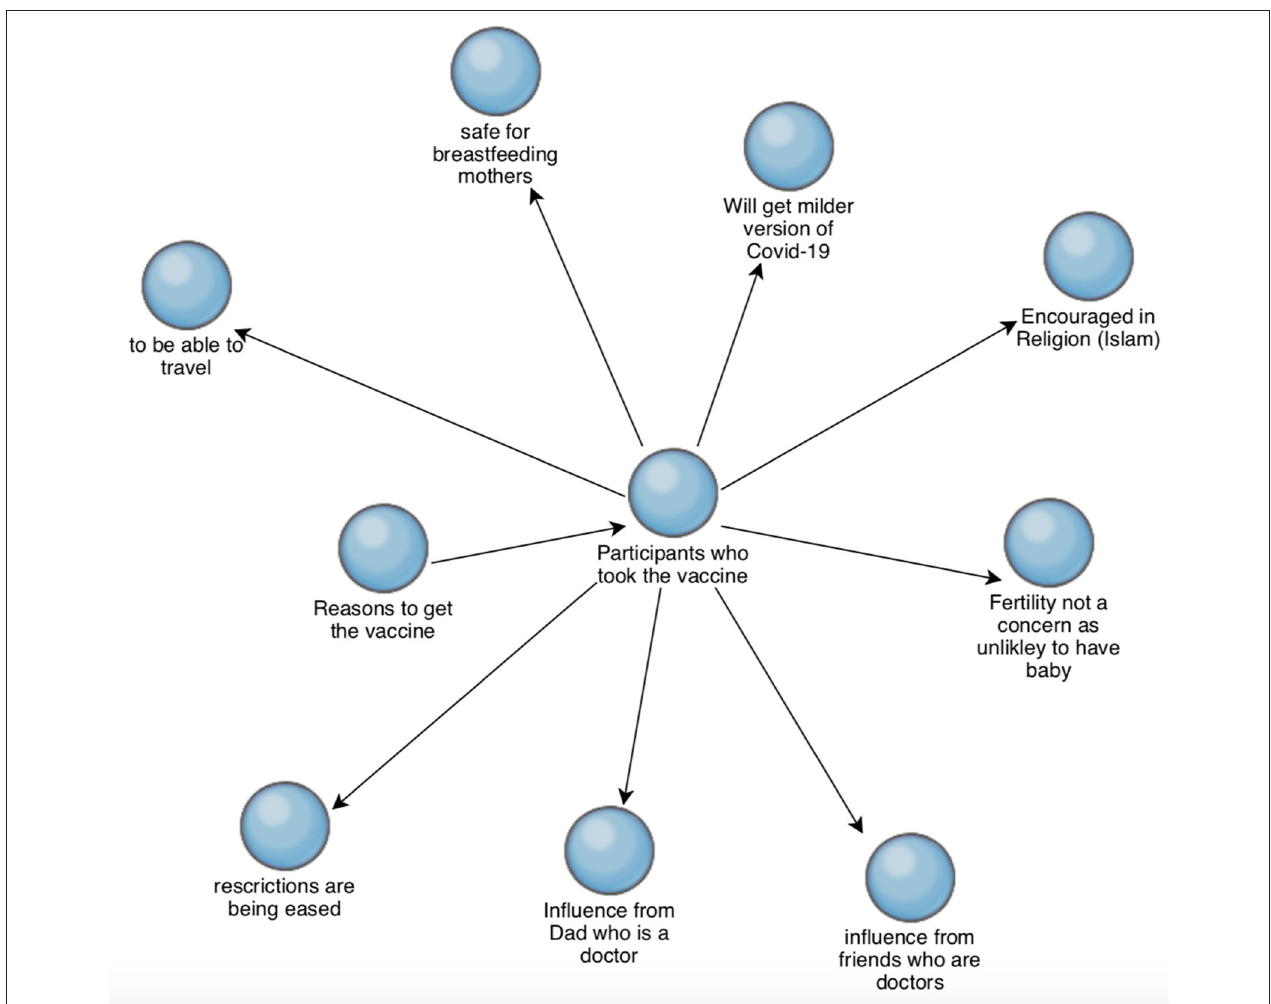
FIGURE 3 | Motivations for potentially receiving the COVID-19